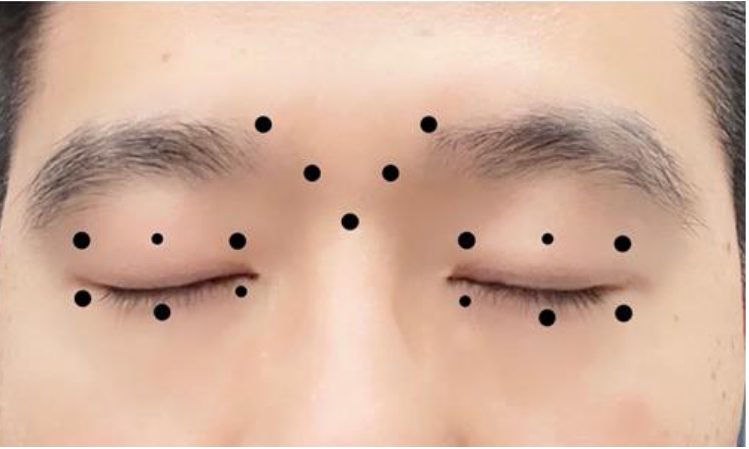
Figure 1. The sketch map of BoNT-A injection sites in blepharospasm patients with dry eye. Big dots represent 4 units and small dots mean 2 units of dose injected.